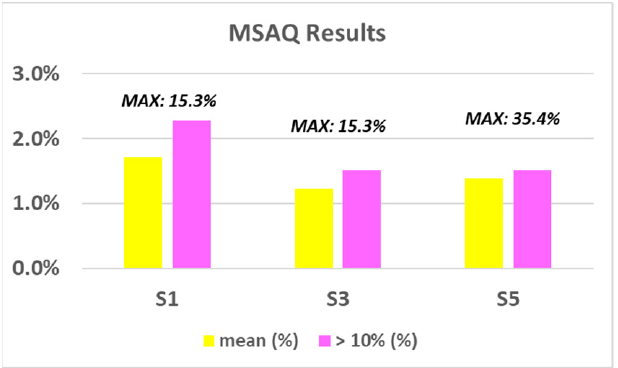
Figure 16. Motion Sickness Assessment Questionnaire (MSAQ) summary.